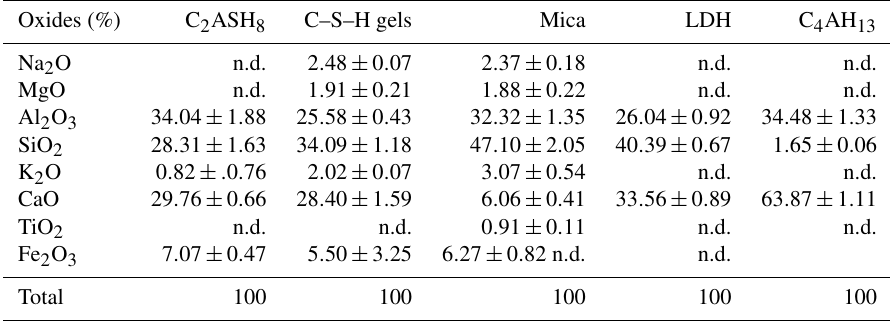
Figure 3. (a) LDH compounds and C–S–H gels from APS + FA in ACW. (b) LDH compounds and C–S–H gels from ACW. (c) Stratlingite and C–S–H gels from ACW. (d) Mica, stratlingite and C–S–H gels from ASW. Table 5. Chemical analysis by EDX of the phases at 28